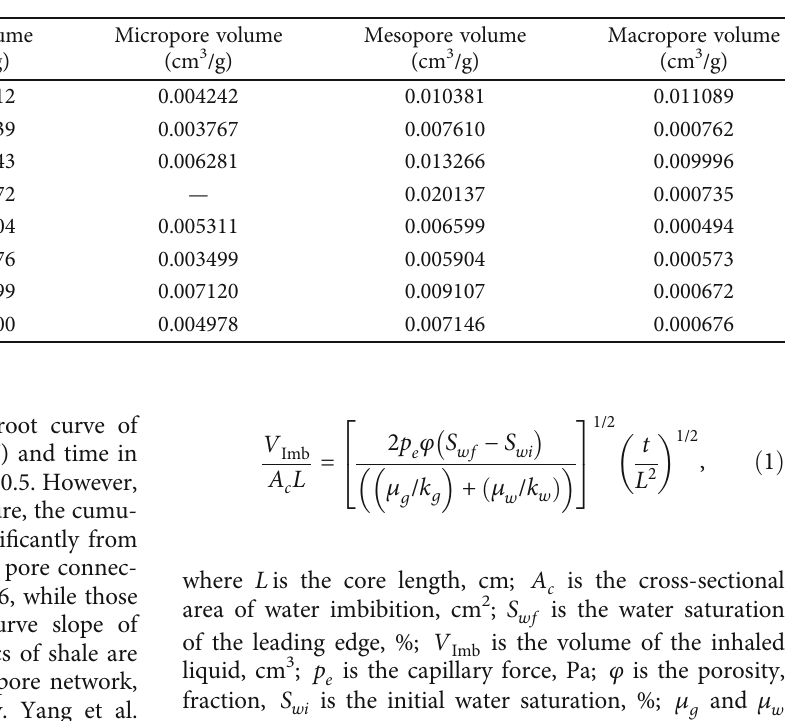
Table 5: Pore structure parameters of the deep shale samples.